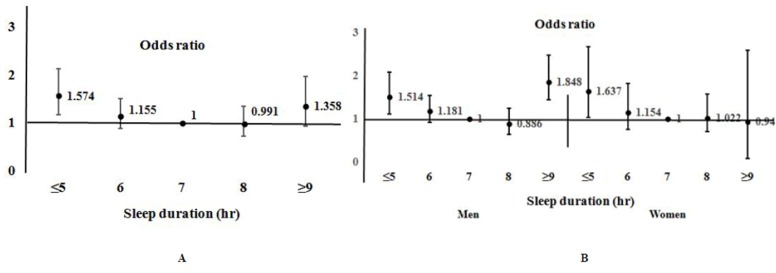
The odds ratio of dysphonia that lasts more than three weeks by sleep duration.(A) Data for all participants and (B) data for men and women.